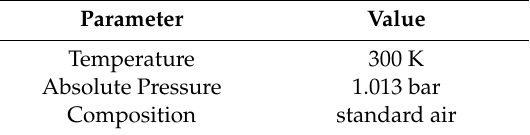
Table 5. Parameter settings of the simulation module of atmospheric